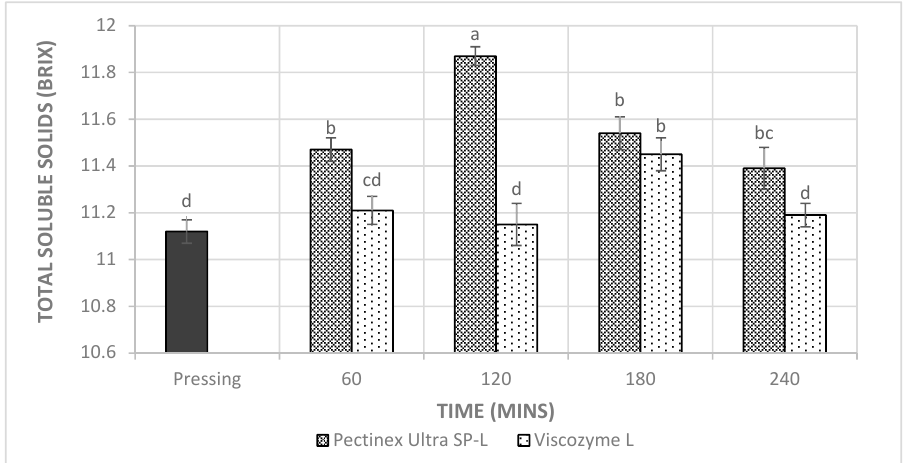
Figure 2. The effects of enzyme treatments on the total soluble solids of mulberry juice. The values are mean ± SD ( n = 3). Means sharing different letters are significantly different ( p < 0.05).